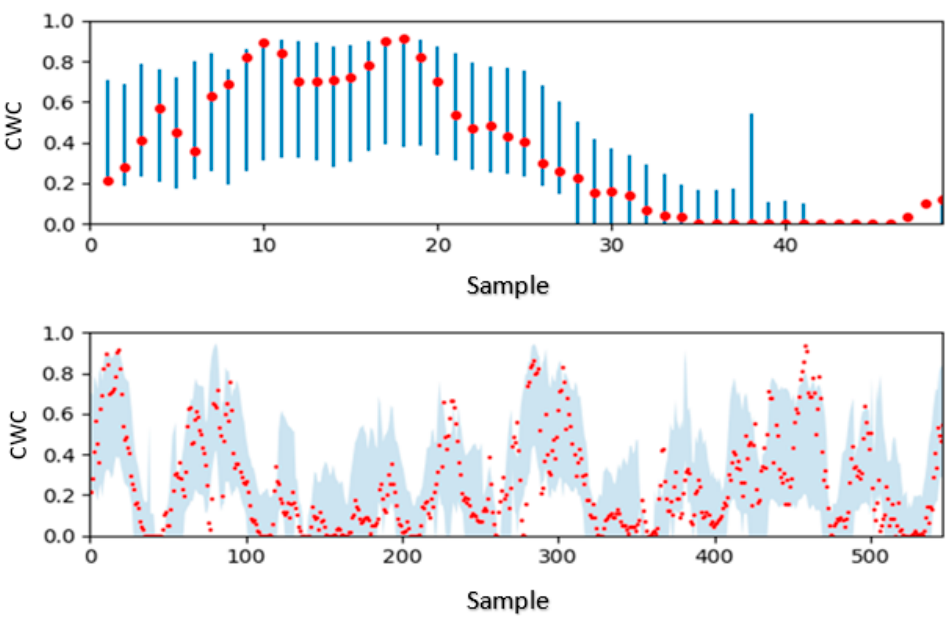
Figure 9. PIs generated by WT-LUBE-PSO-CWC for the autumn 2012 dataset of zone 7.